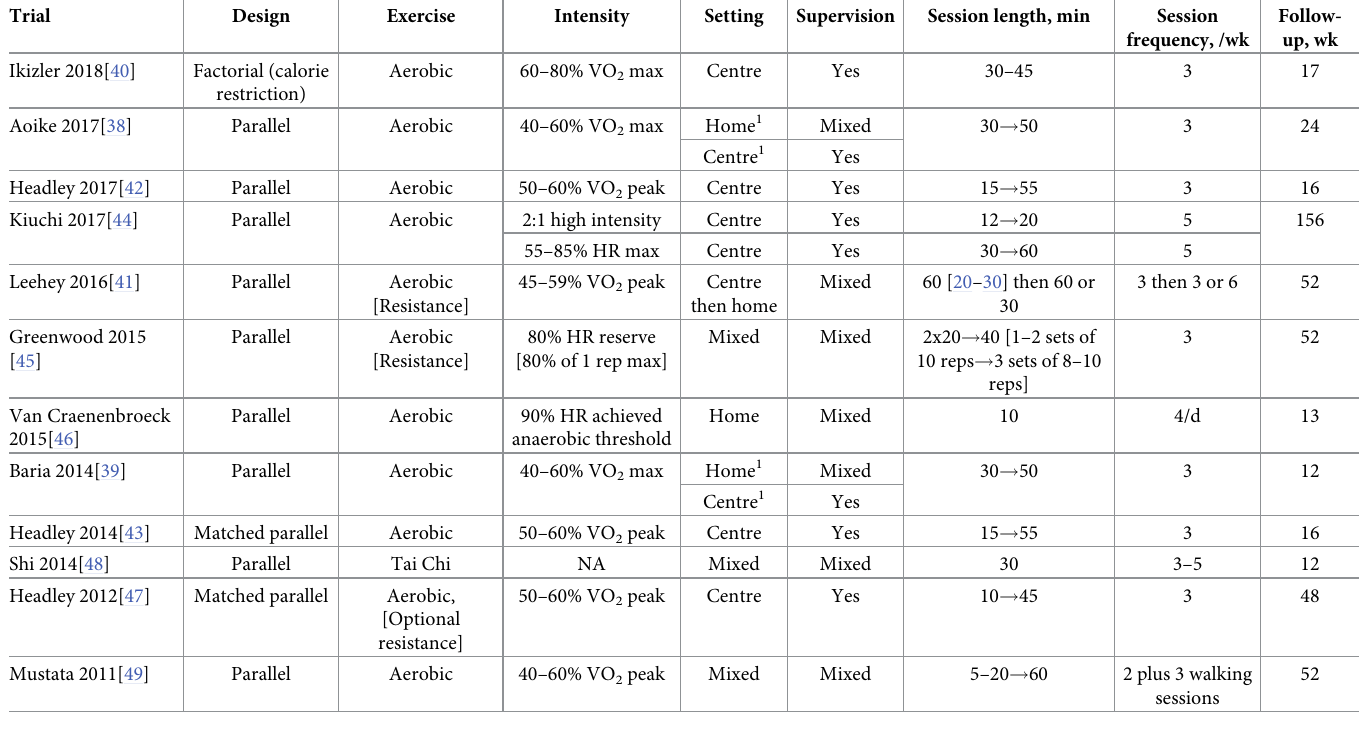
1 Participants selected their exercise setting, that is, setting was not randomized. A dash indicates that information was not reported. Arrows indicate duration at the start of the intervention and the targeted progression